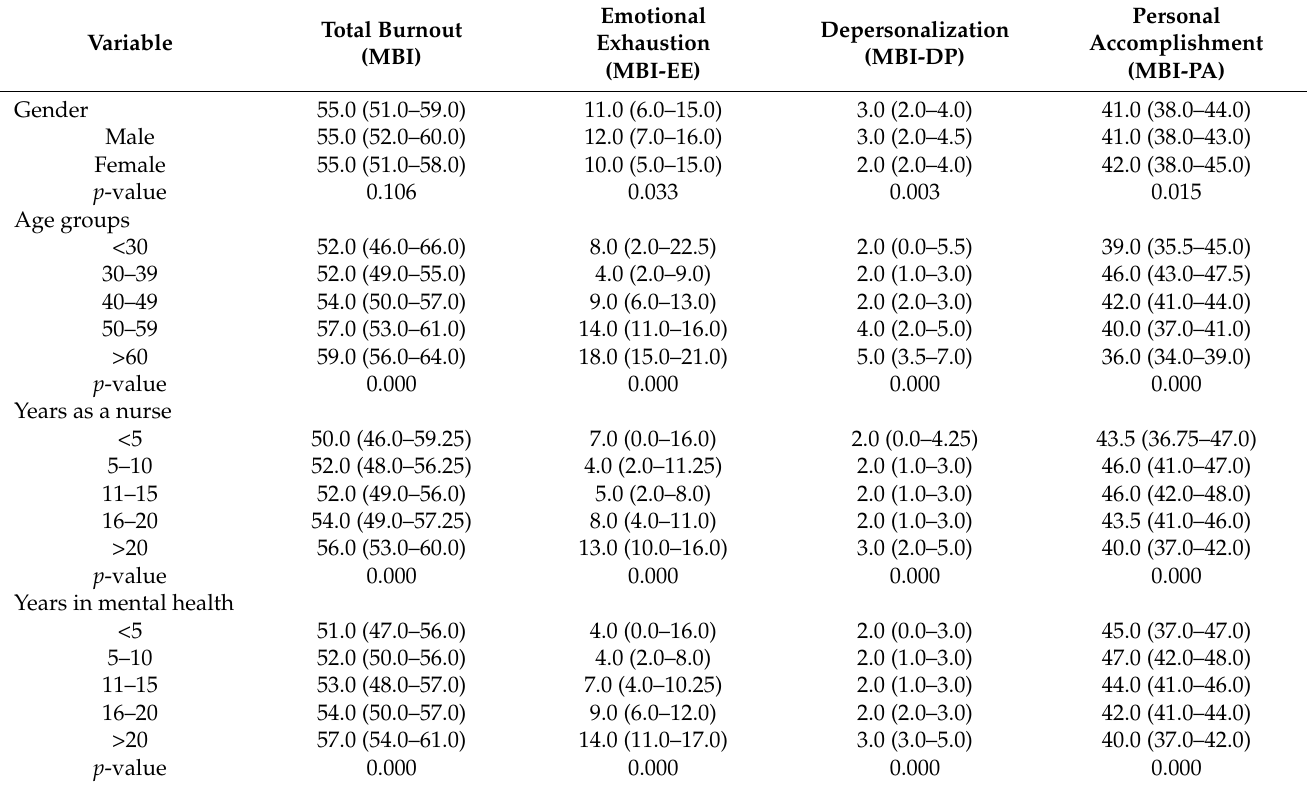
Table 4. Association between burnout and sociodemographic